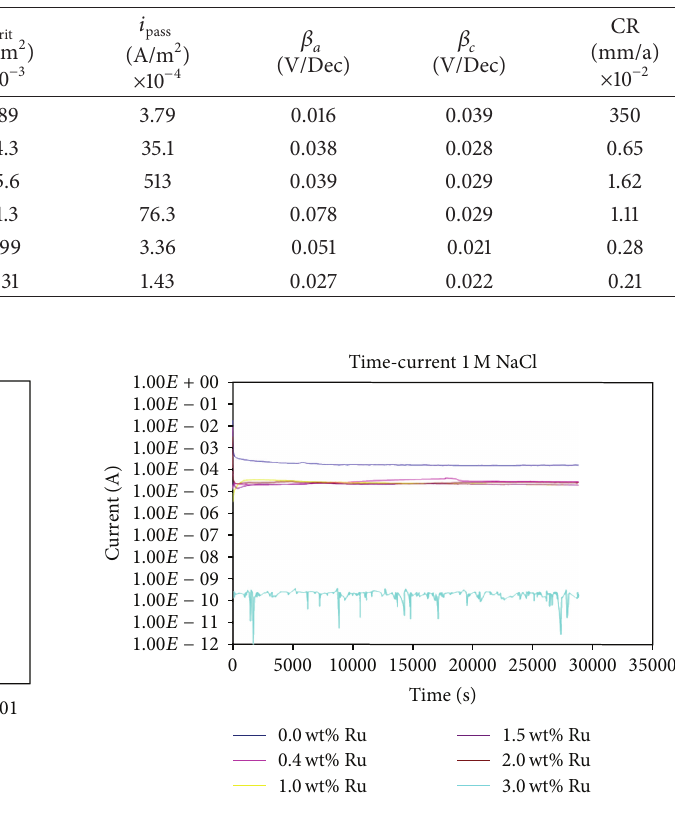
Figure 3: Current-time responses of the WC-Co-Ru samples exposed to 1 M NaCl at an applied potential of 700 mV versus Ag/AgCl reference